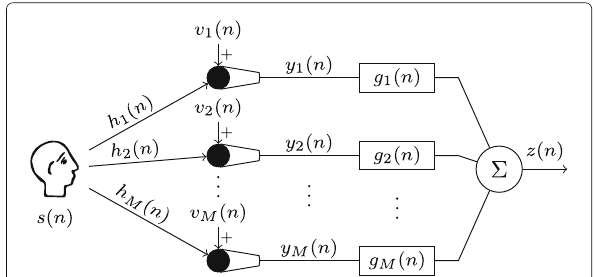
Fig. 1 Acoustic system configuration